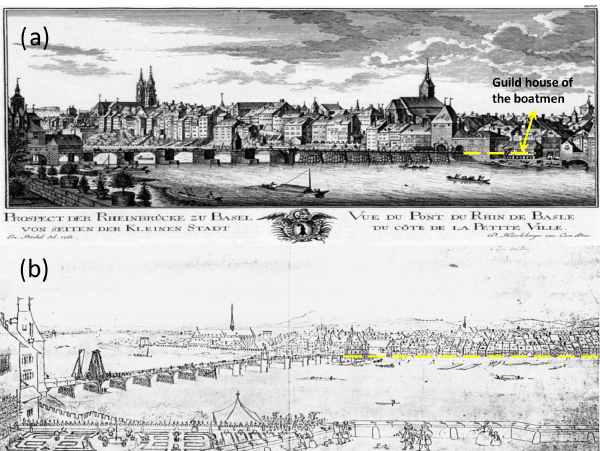
Figure 2. Hydrological plausibility check of referenced landmarks in chronicler reports about the Rhine River floods of 1424 and 1480. (a) Blick auf das linke Rheinufer, 1759; artist: Emanuel Büchel, StABS, Collection Weber-Oeri, Topo 2. (b) Blick vom Rheinsprung auf die Rheinbrücke und Kleinbasel mit Hinterland, 1767; artist: Emanuel Büchel, StABS, Collection Weber-Oeri, Topo 2.